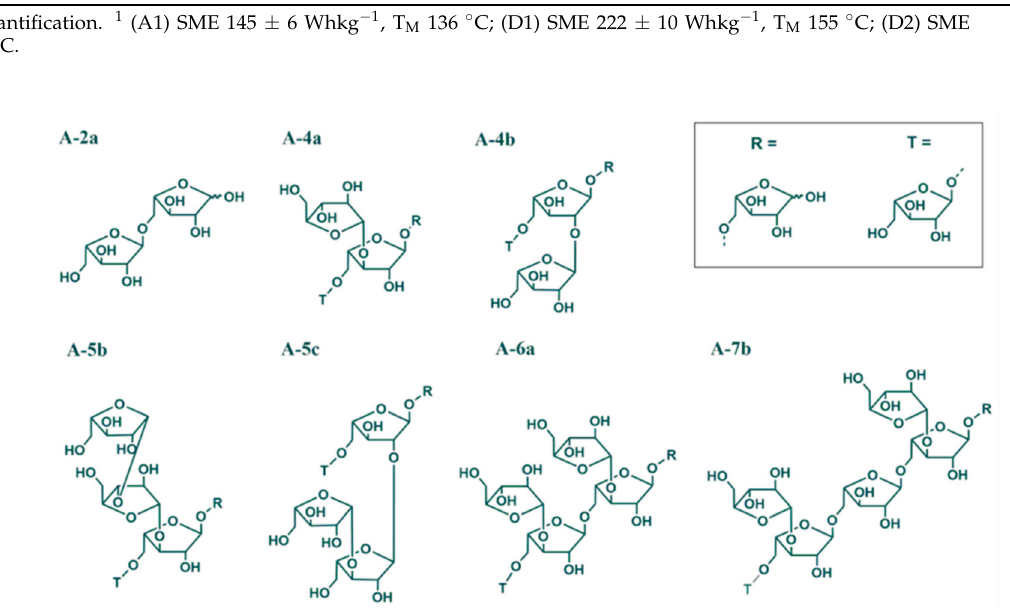
Figure 3. Pectic arabinan oligosaccharides liberated by endo-arabinanase from dietary fiber fractions isolated from chokeberry pomace powder (CPP) before and after extrusion processing. T, terminal end; R, reducing end